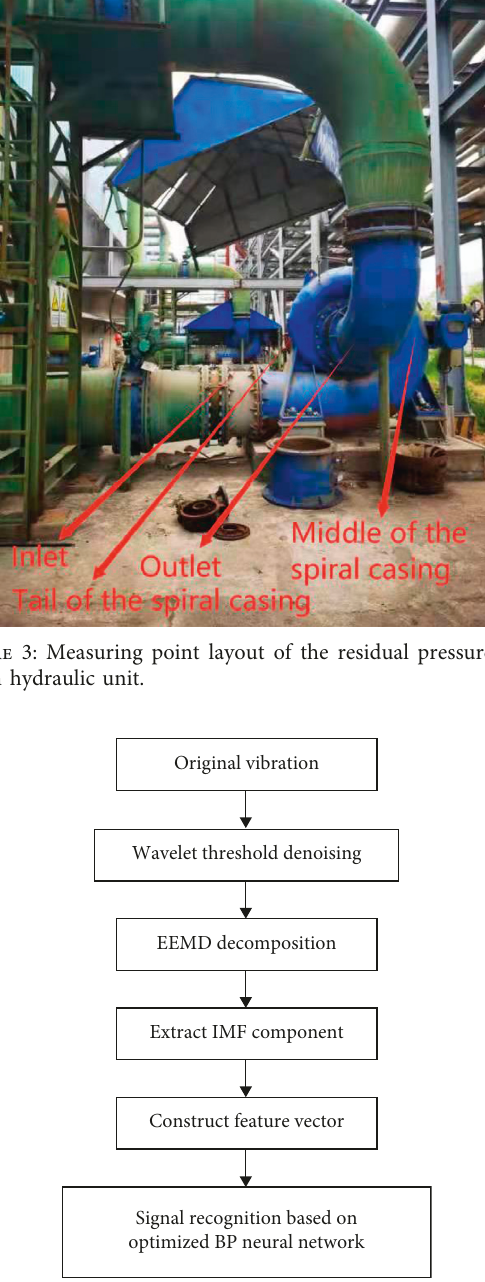
Figure 4: Feature extraction process based on